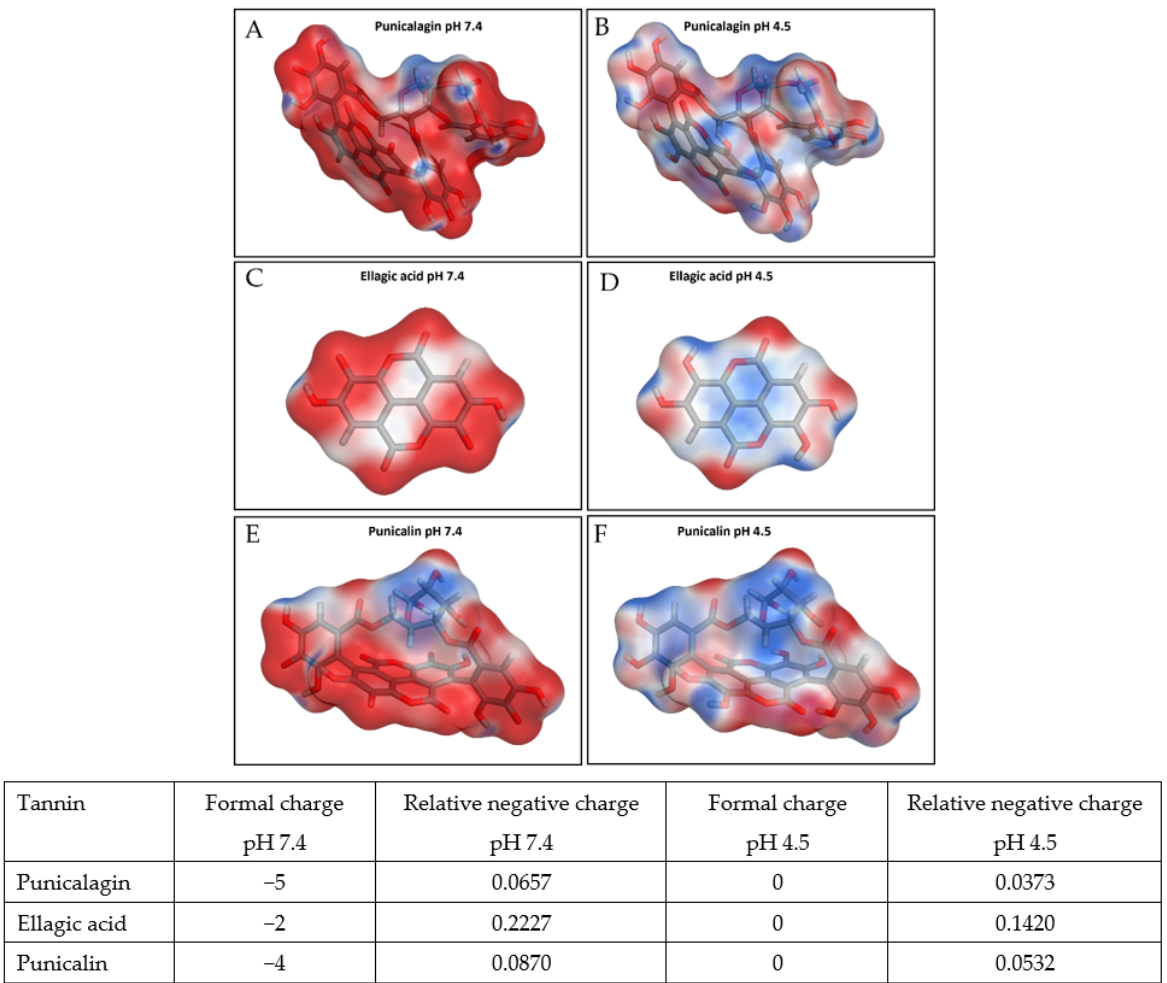
Figure 6. Electrostatic surface maps of punicalagin, ellagic acid, and punicalin at pH 7.4 and pH 4.5. Punicalagin, like other tannins, possesses a negative charge at pH 7 4; however, they are all neutral with almost equal distribution of electrostatic charge positive and negative at pH 4.5. The areas colored in red and blue represent respectively negative and positive regions of the electrostatic potential. Table contains computed charges for punicalagin, ellagic acid, and punicalin, confirming absence of charge at pH 4.5.